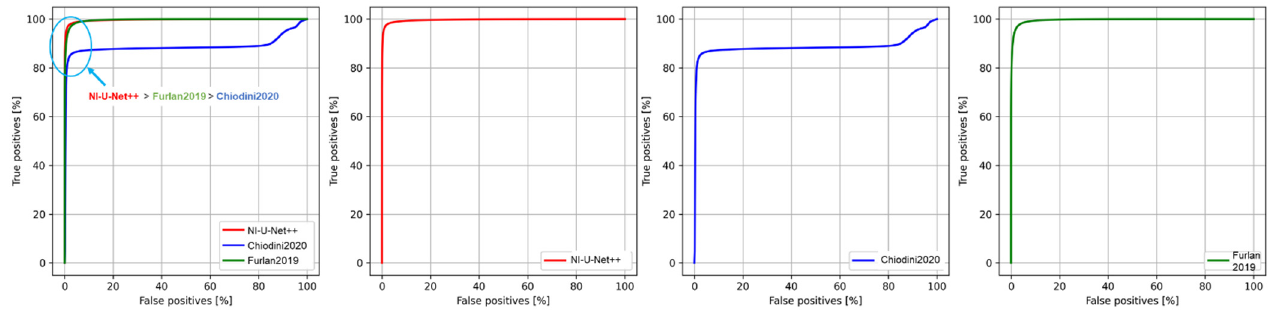
Figure 8. The ROC curves of the proposed NI-U-Net++, Furlan2019 [43], and Chiodini2020 [44].